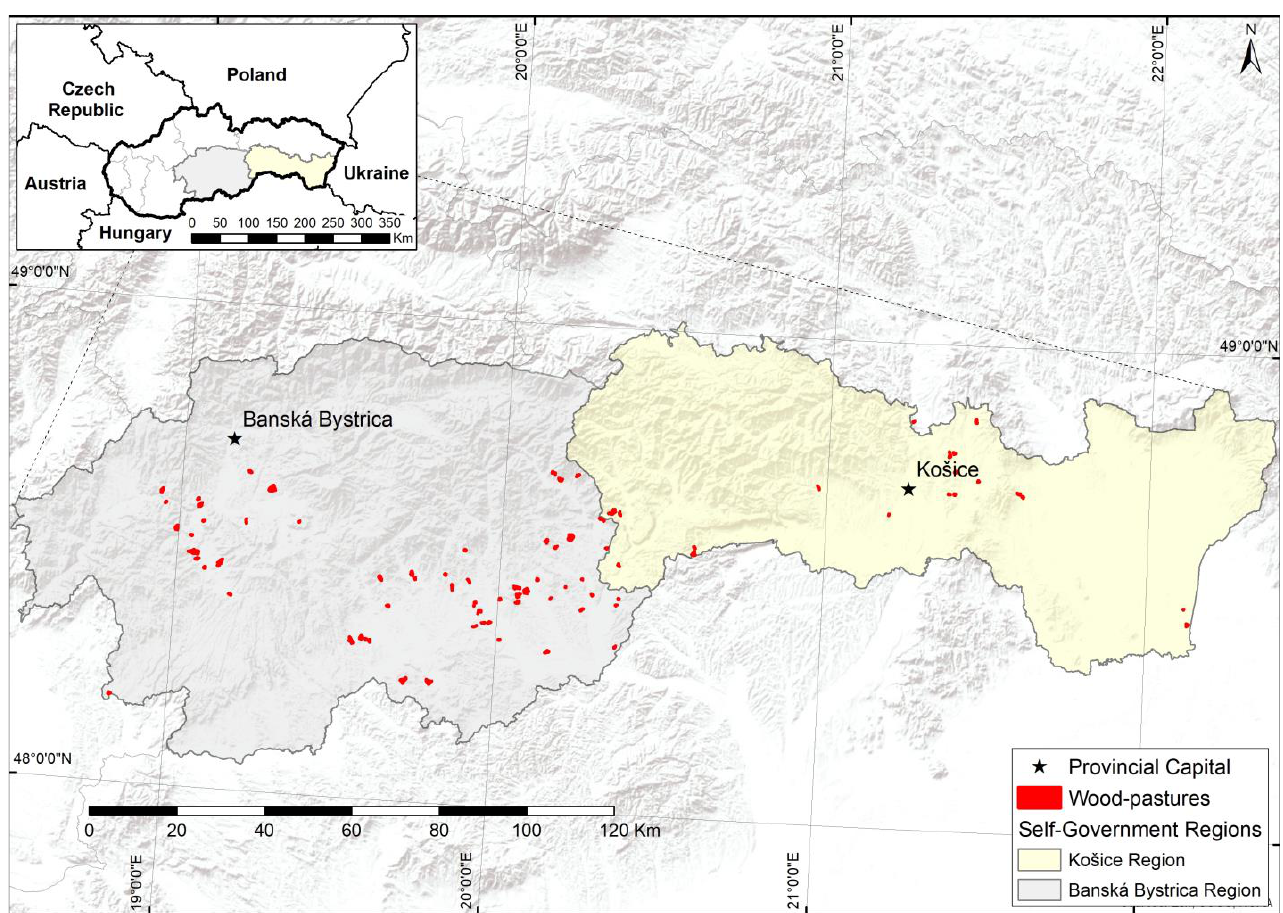
Figure 1. Location of intact wood-pasture habitats based on aerial photographs from early 1950s.